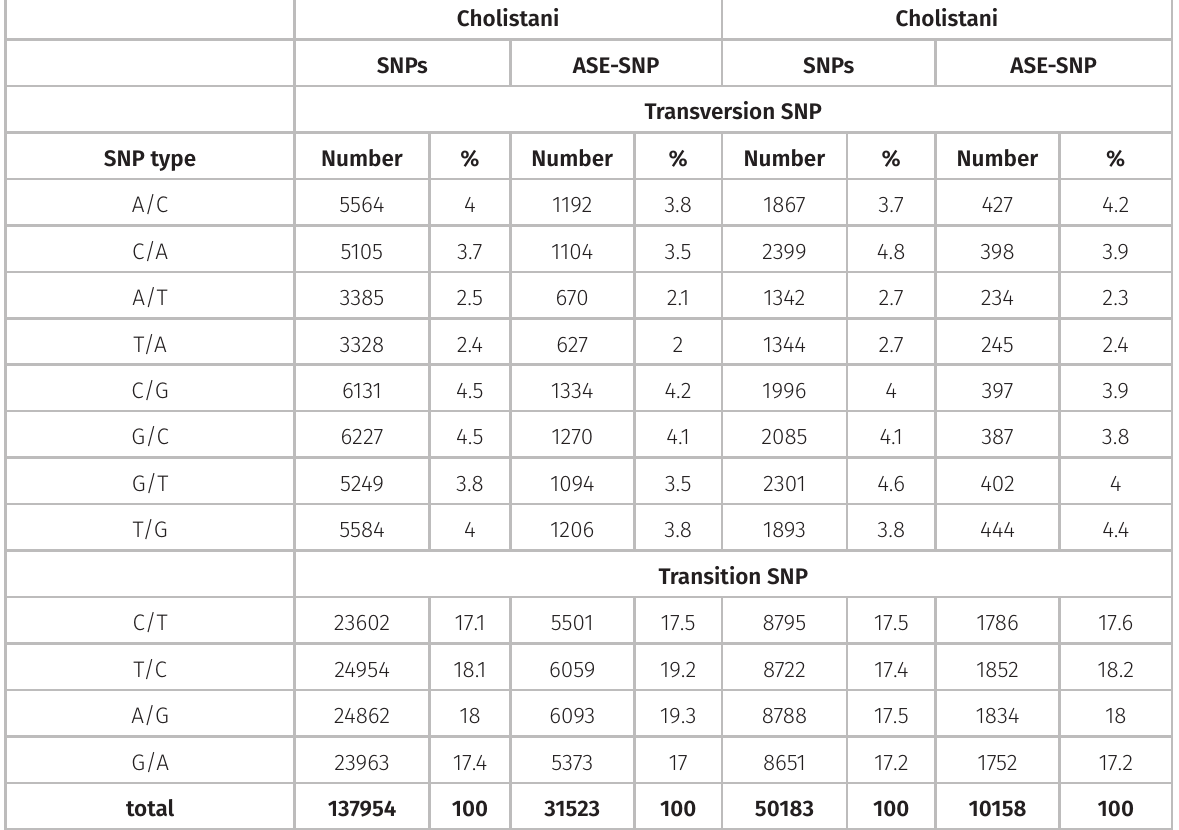
Table II. SNP and ASE-SNP types in Holstein and Cholistani cows. CholistaniCholistani